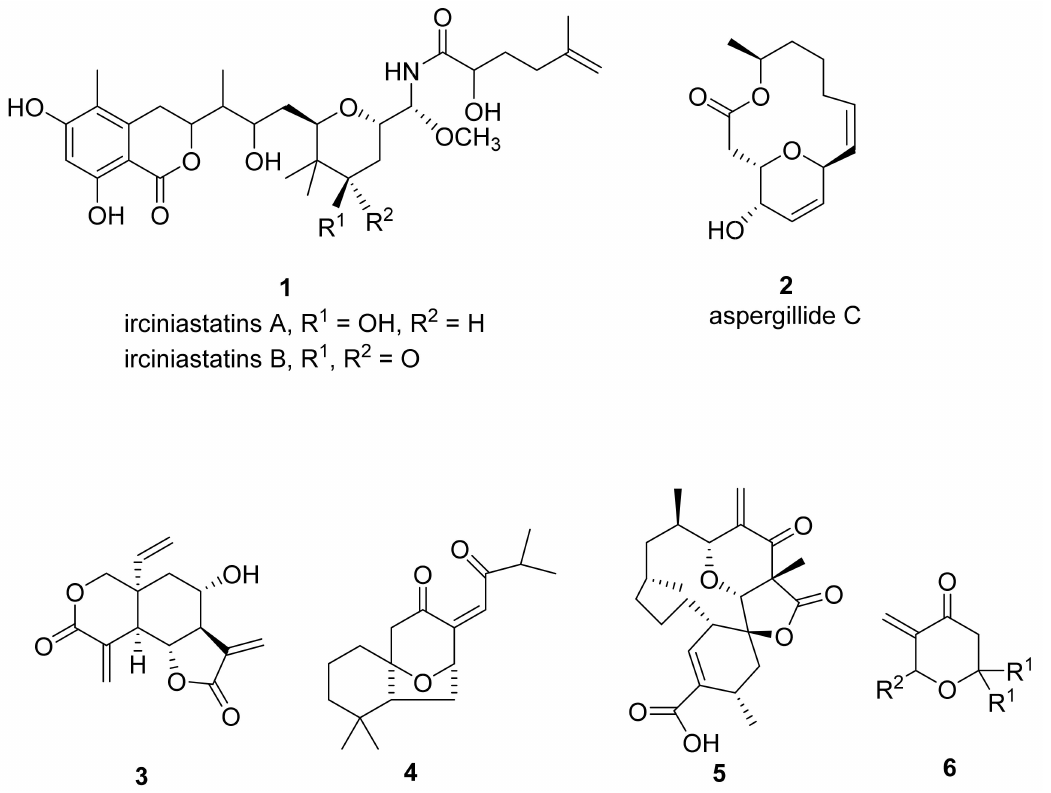
Figure 1. Compounds containing tetrahydropyrane ring with anti-HBV or cytotoxic